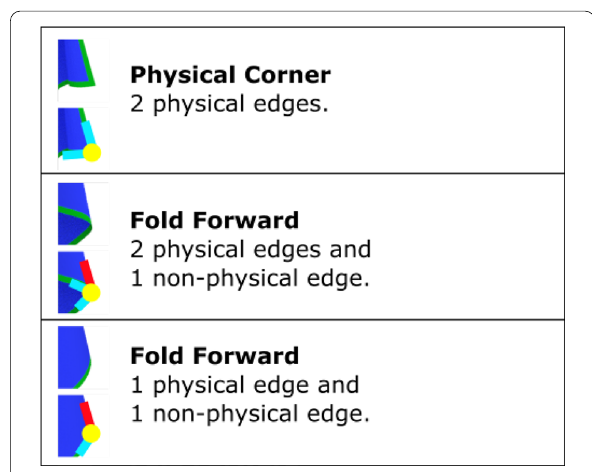
Fig. 4 The three possible configurations of the leftmost and rightmost corners of the cloth depth image